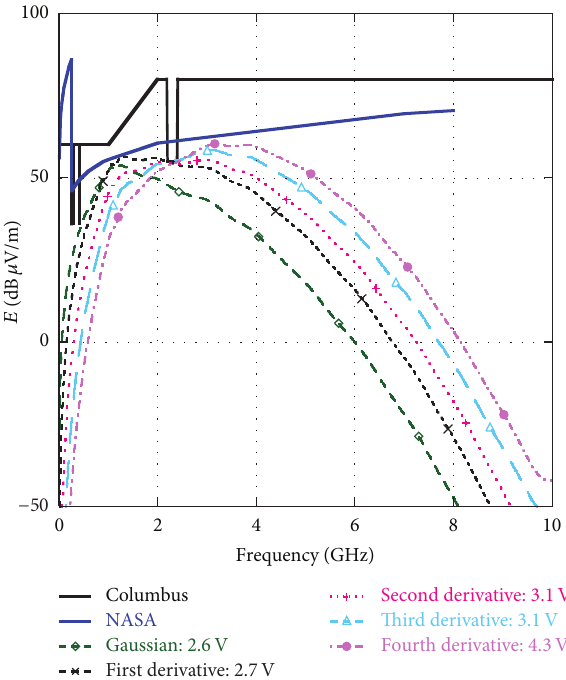
Figure2:Computed E -fieldforvariouspulseshapes.Themaximum pulse amplitude that gives rise to an E -field level in compliance with Columbus and NASA emission mask is